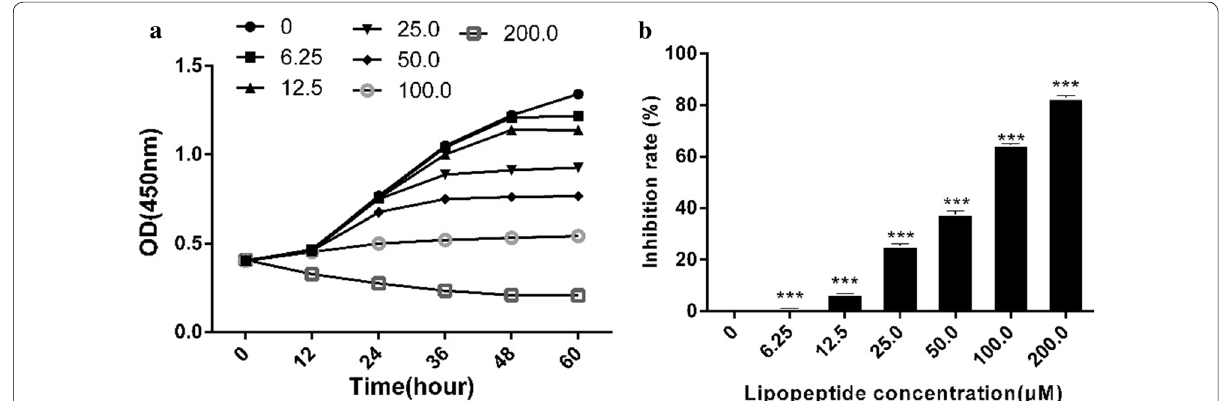
Fig. 1 Effect of B. subtilis lipopeptides on the viability of K562. a The viability of K562 cells was measured at different periods; the concentration unit was μM. b The inhibition rate was calculated according to the data at 48 h; the significance analysis was performed on the data for treated and control samples using the software GraphPad Prism 6.0. (P <